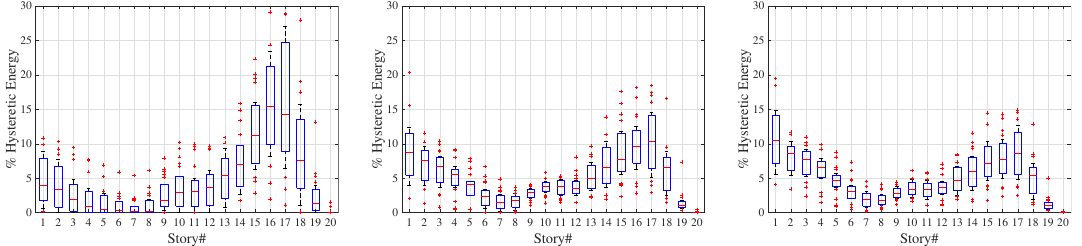
Figure 6. Distribution of hysteretic energy demands over the height of the buildings for ( a ) 10/50, ( b ) 2/50 sets ( c ) 1/50